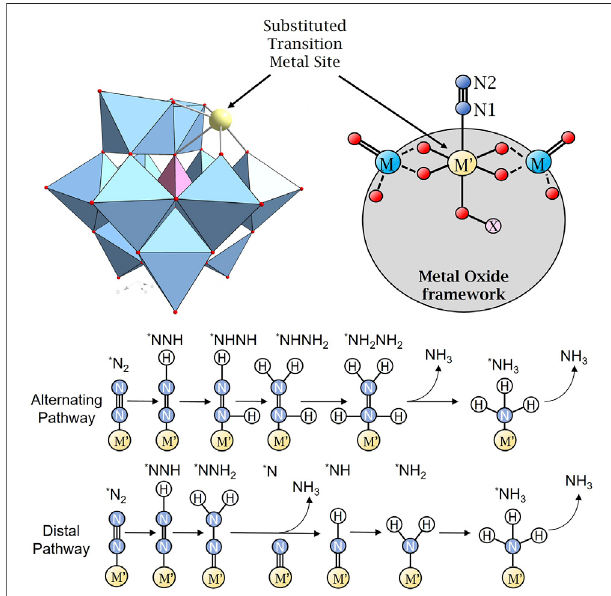
FIGURE 1 | Polyhedral (top-left) representation of mono-substituted heteropolyanion. The nitrogen molecule adsorbs onto the transition metal site through the η 1 (end-on) binding mode. The schematic depiction (top-right) shows the mono-substituted heteropolyanion in the nitrogen-bound state. Below this, a schematic depiction of the associative mechanisms for nitrogen reduction in which the N-N bond is cleaved simultaneously with the release of ammonia. The associative mechanism can proceed via two separate pathways —“ alternating ” and “ distal ” which invoke distinctly different intermediates. Colours corresponding to addenda metal (cid:1) Cyan; substituted metal (cid:1) yellow; heteroatom (cid:1) Pink; O (cid:1) red; N (cid:1) dark blue; and H (cid:1)